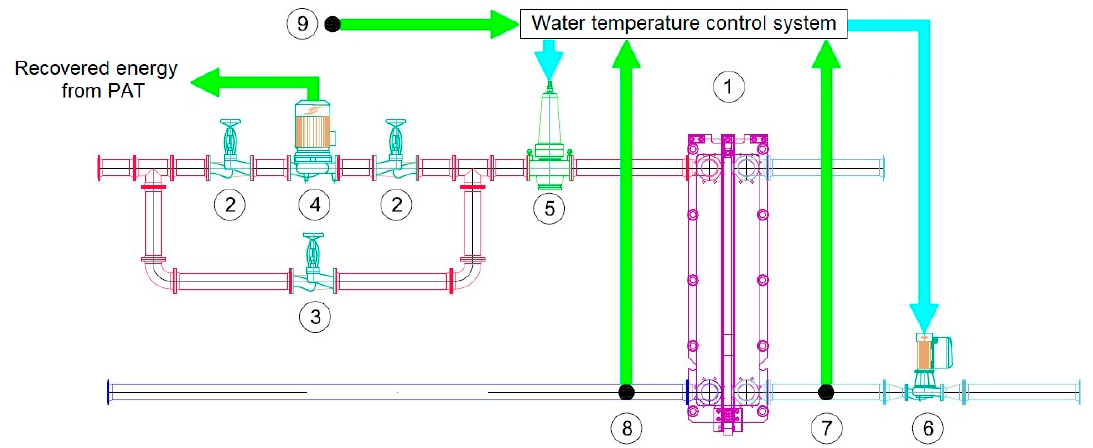
Figure 15. Pump as turbine (PAT) location scheme: 1—HX; 2—Control valve; 3—By-pass pipe; 4—PAT; 5—PRV; 6—Circulating pump; 7—Secondary circuit temperature sensor; 8—Primary circuit temperature sensor; 9—Outdoor temperature sensor.